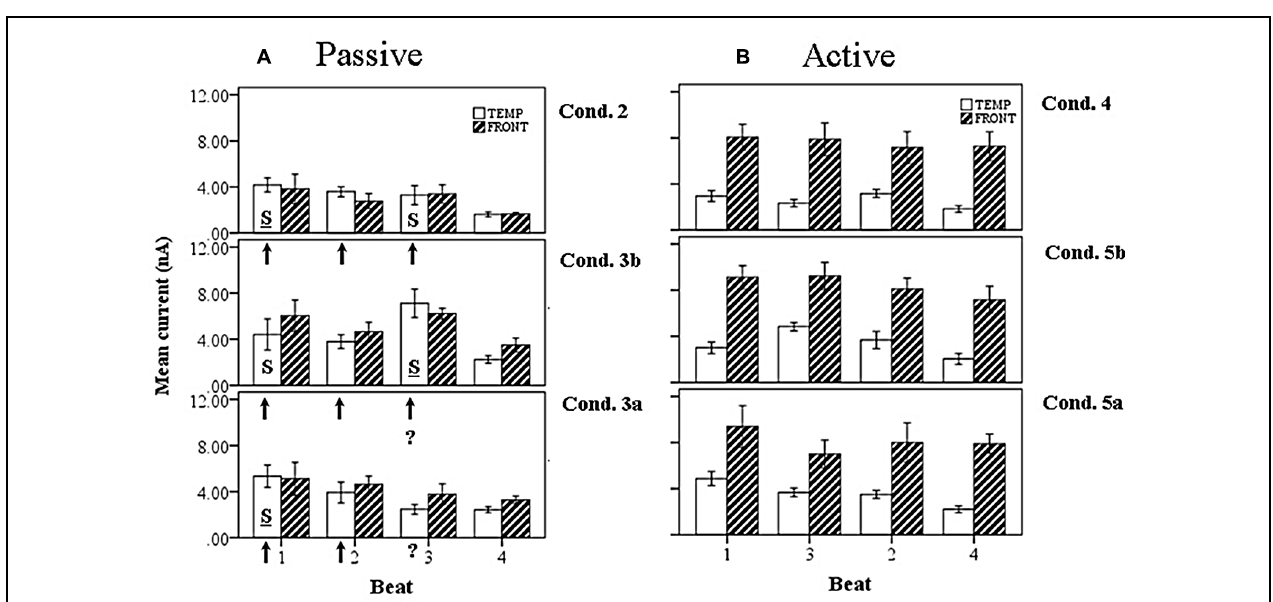
standard error. The arrows indicate the alignment of the click stimulus. In the passive conditions the current activity on beats 1 and 3 is relatively larger than on beats 2 and 4, indicated by the labels S-W-S-W.